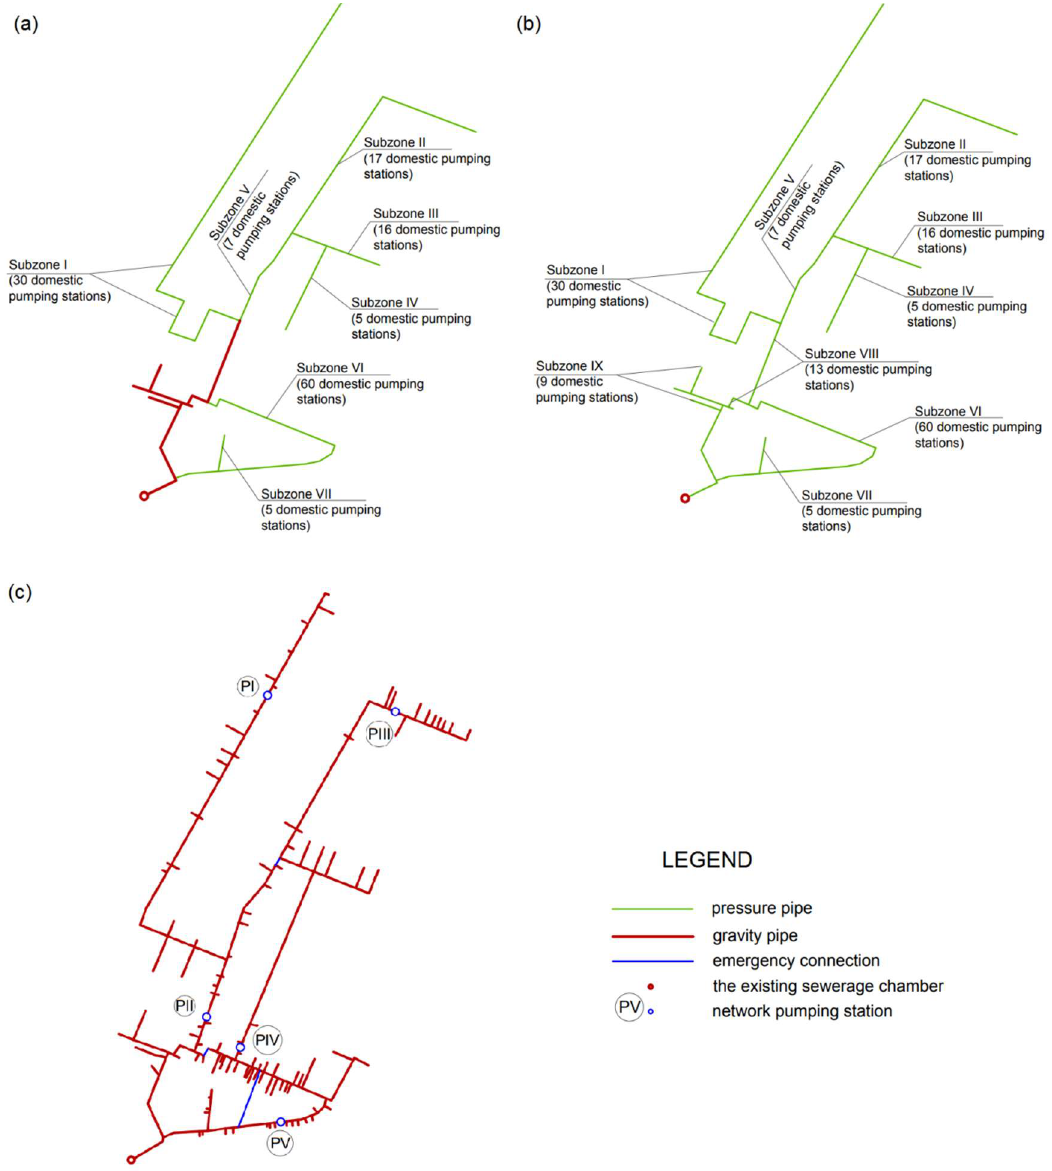
Figure 3. Schemes of developed variants of sewerage system network for the Zagrody settlement: ( a ) Variant I, ( b ) Variant II, ( c ) Variant III.